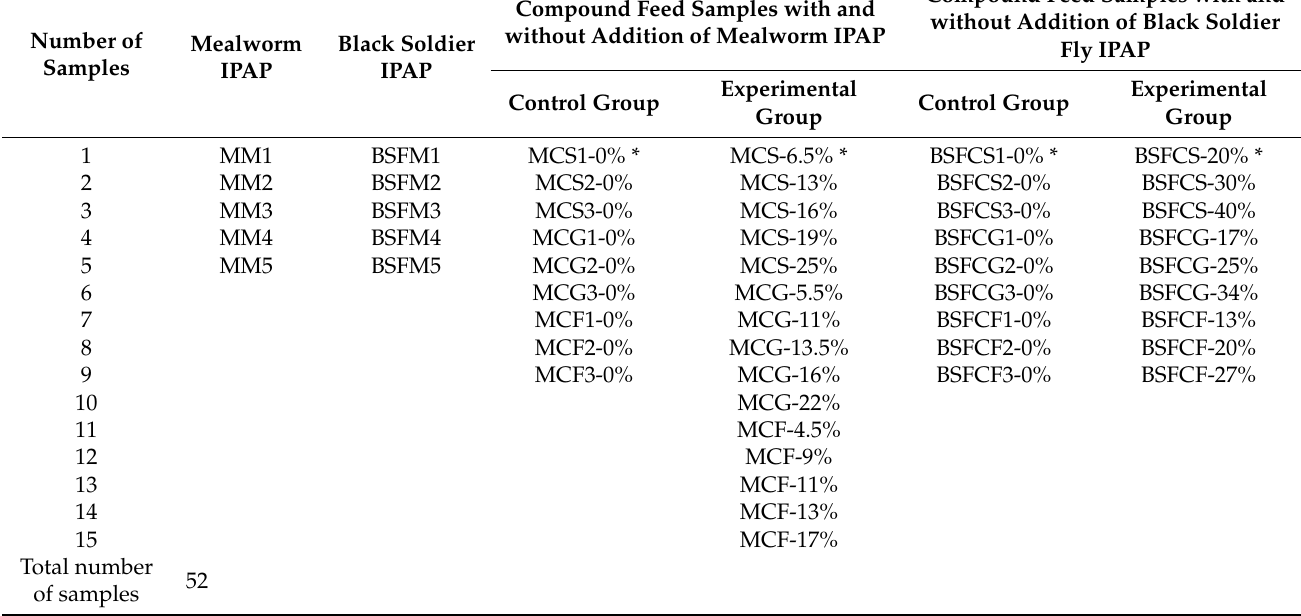
Table 1. Insect processed animal protein (IPAP) and feed samples analyzed during the